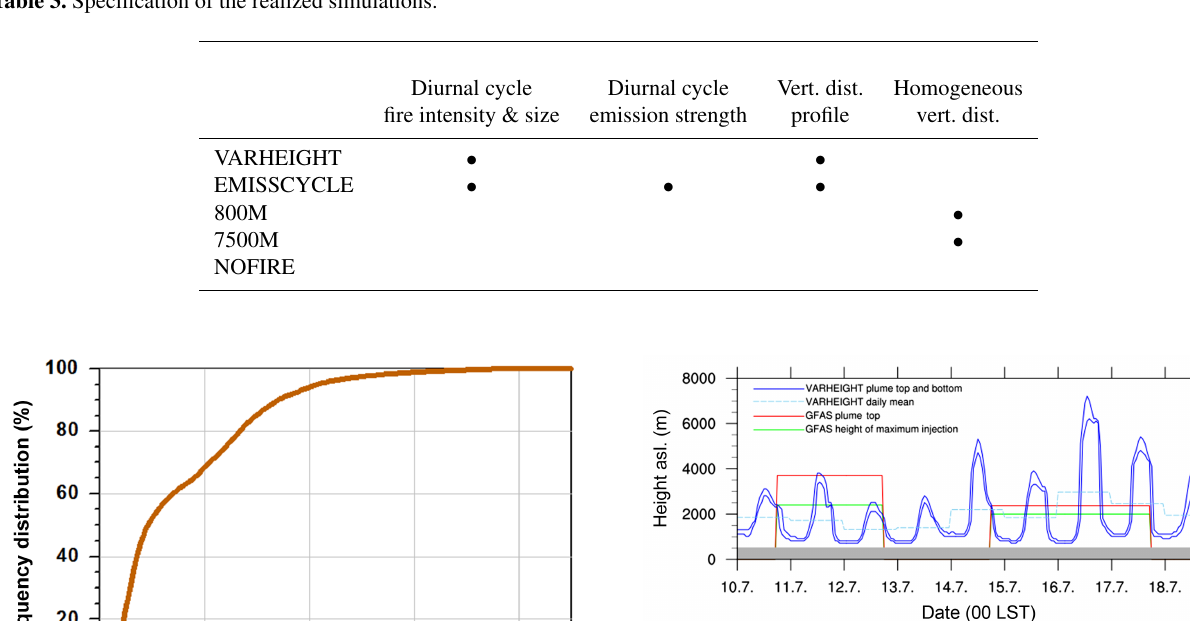
Figure 5. Time series of the plume height at one fire location. The lower and the upper bound of the effective emission layer simu- lated by the plume rise model within COSMO-ART (blue lines). The dashed light blue line gives the daily mean of these heights. Plume heights specified by GFASv1.2 for two derivations (red and green